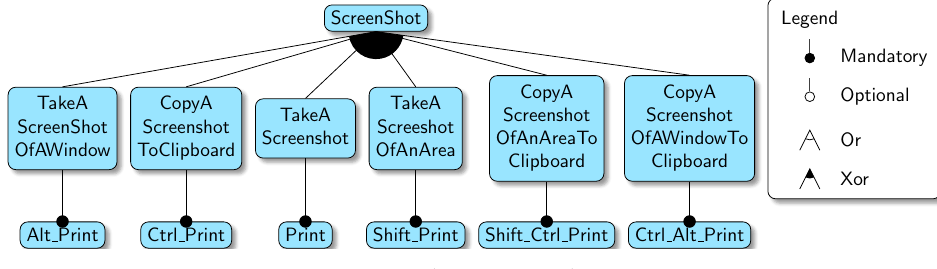
Figure 3. A Ubuntu screenshot FM.